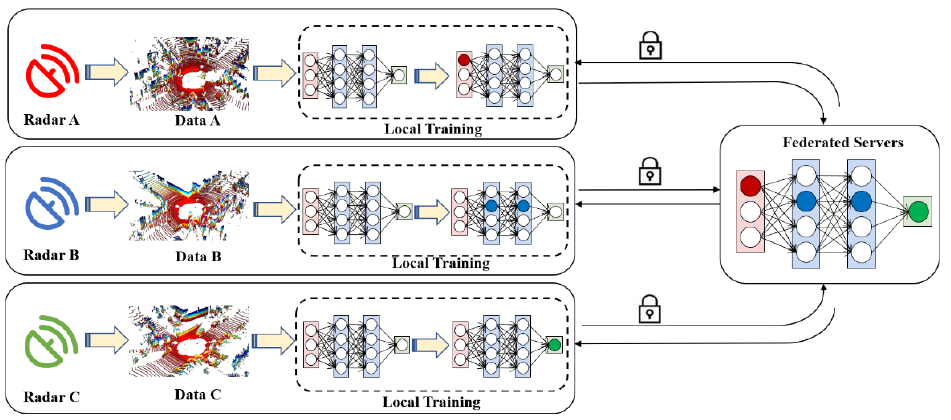
Figure 7. Federated Radars: The Framework and